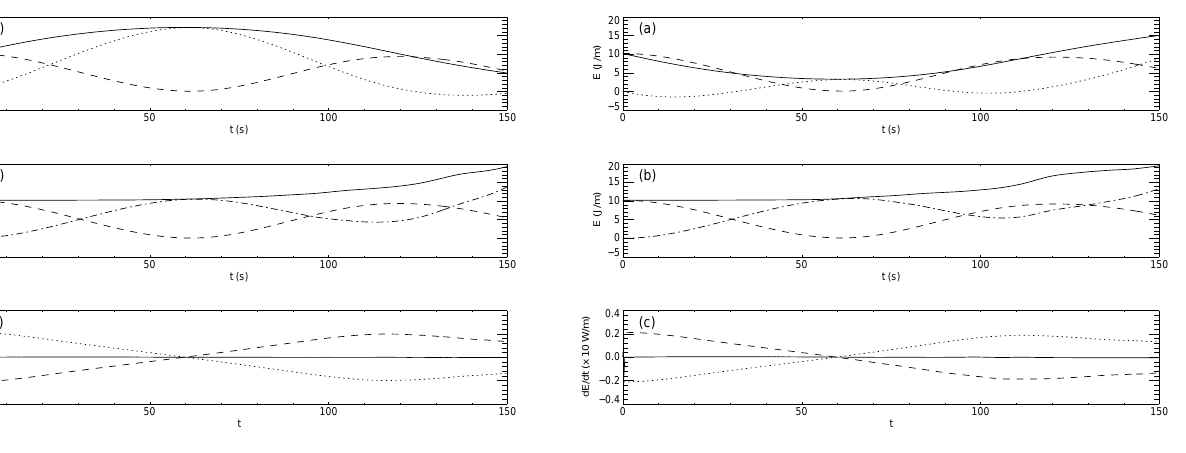
¯ E ¯ E a . Solid: their sum. k2 . Dashed: